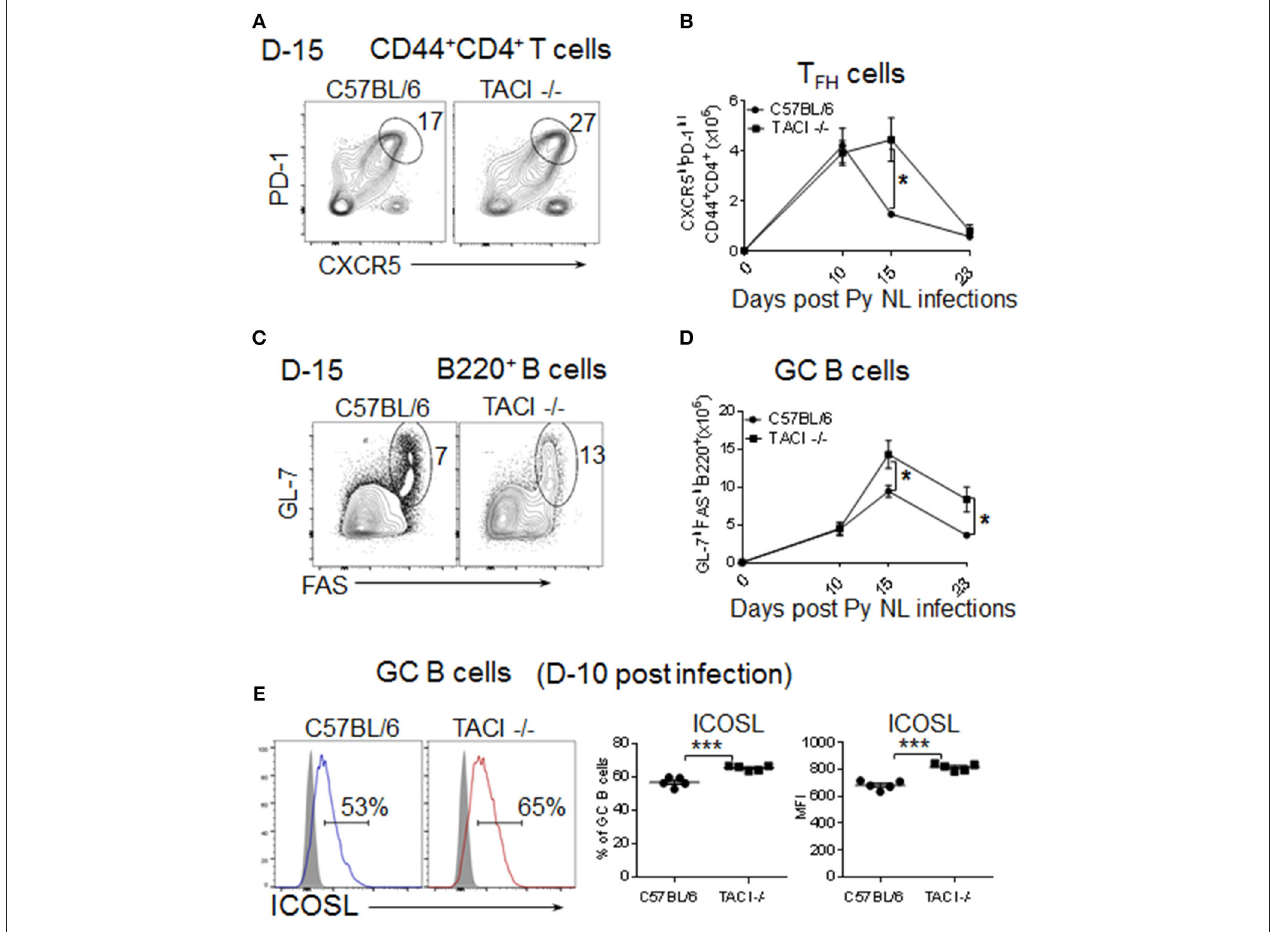
FIGURE 2 | TACI deficiency extends formation and resolution kinetics of T FH and GC response. TACI -/- and C57BL/6 mice were infected (i.p.) with 1 × 10 6 P. yoelii (Py 17XNL strain) parasites. (A) Representative dot plots depict the percentage of splenic PD-1 high CXCR5 high (T FH ) cell on CD44 + CD4 + pre-gated T cells at day 15 post-infection. (B) Formation and resolution kinetics of T FH cells presented as number of T FH cells per spleen. (C) Representative dot plots depict the percentage of and GL-7 hig hFAS high (GC B cells) on B220 + pre-gated B cells at day 15 post-infection. (D) Formation and resolution ki“netics of GC B cells presented as number of GC B cells per spleen. Total splenic B cell (E) Day 10 post-infection ICOSL expression levels were measured on B220 + GL-7 high FAS high gated splenic GC B cells. Representative histograms as well as frequencies of ICOSL expressing cells and ICOSL MFI for each mouse strain are shown. Unpaired Student’s t -test was used for statistical evaluation. Results are expressed as mean ± SEM ( n = 5) from one representative experiment out of three with similar results. * p < 0.05 and *** p < 0.001 for TACI -/- vs. C57BL/6 comparison. GC, germinal center.